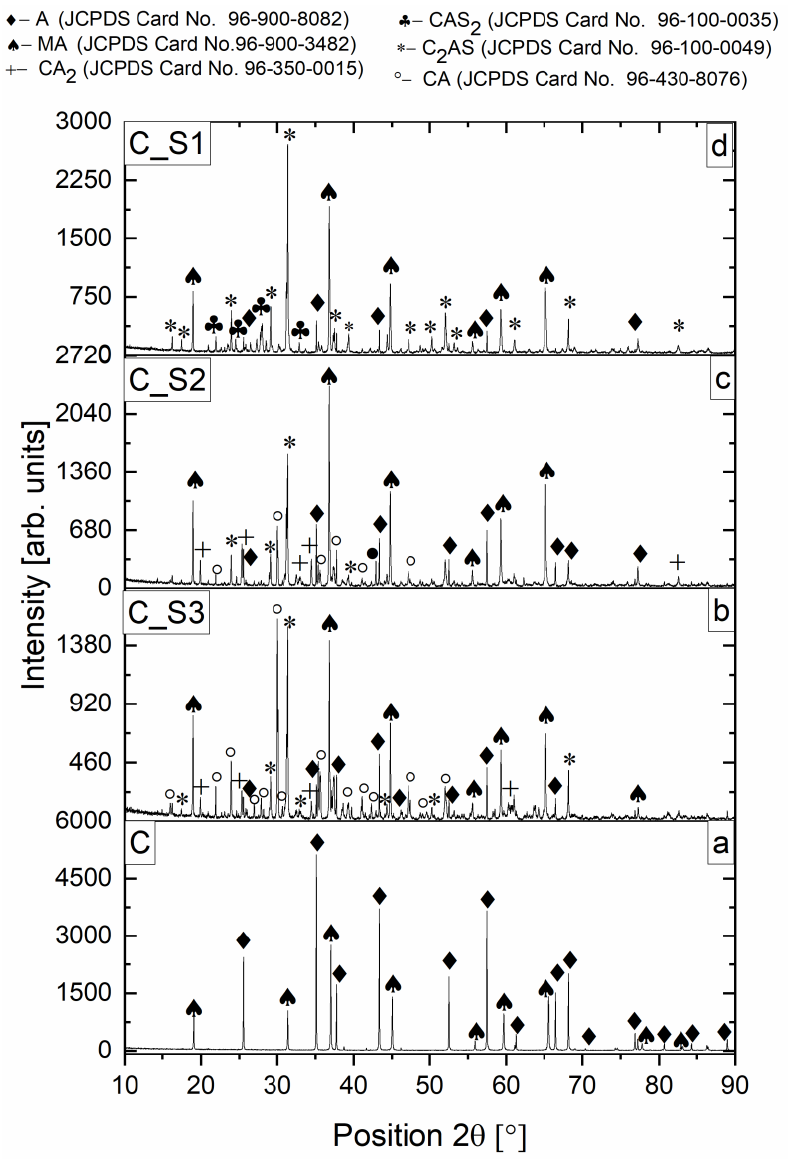
Figure 11. ( a – d ) X-ray diffraction of castable C (7 wt.% MgO) and mixtures (50 wt.% slag and 50 wt.% castable) with castable C and slags: S1, S2, S3 after firing at the maximum temperature of 1350 °C for 2 h. Both qualitative and quantitative (Rietveld) analyses were performed. Castable C Table 4. Rietveld analysis of corroded mixtures 50 wt.% castable: 50 wt.% slag.